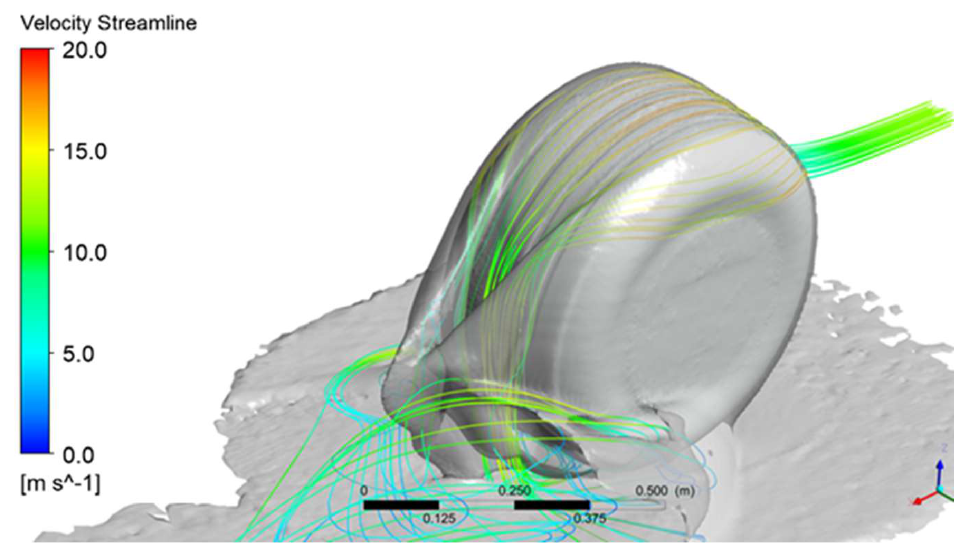
Figure 3. Streamline and vorticity iso-surface on the stationary wheel.